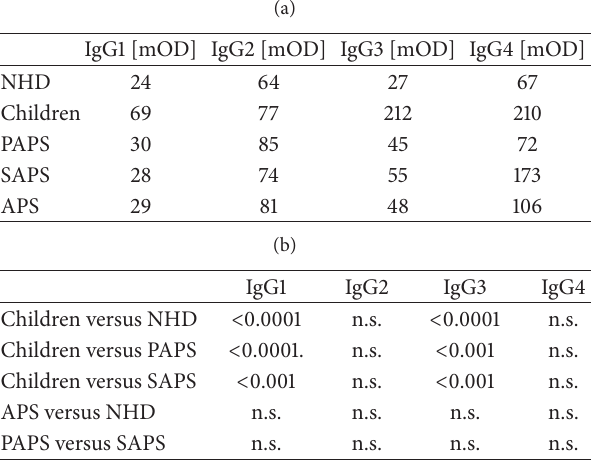
Table 3: (a) OD values of the anti- 𝛽 2GP1-IgG subclasses in the investigated cohorts. (b) Comparison ( 𝑝 values) of the OD values of the anti- 𝛽 2GP1-IgG